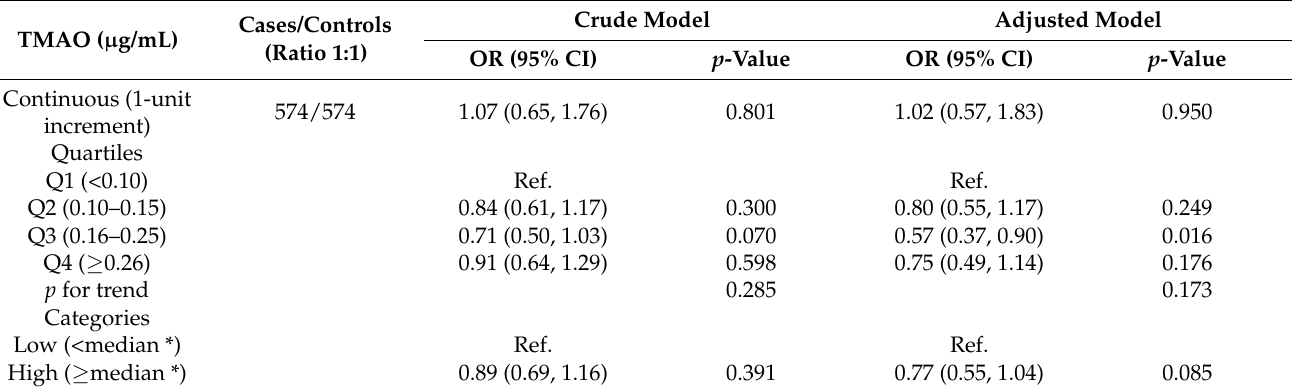
Table 4. The association of TMAO with overall cancer risk.